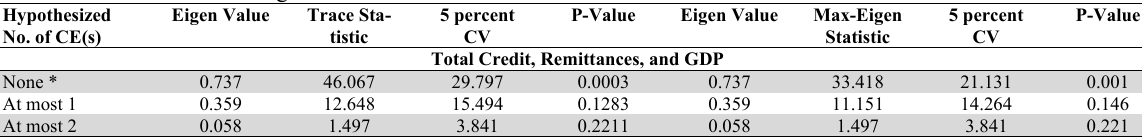
Johansen Multivariate Co-Integration Test Hypothesized No. of CE(s)